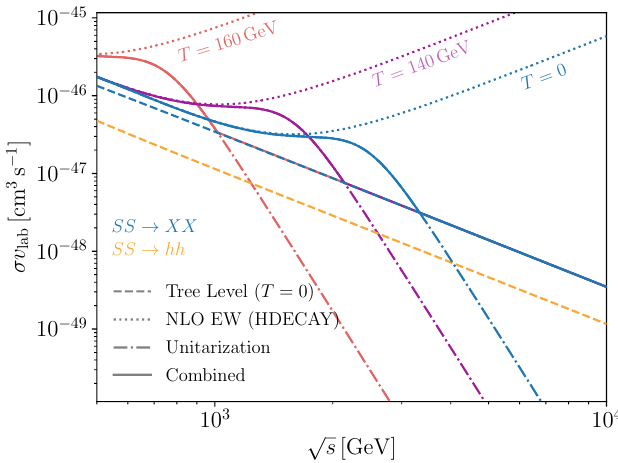
Figure 2 . Total annihilation cross section for the toy model introduced in eq. (4.6), for λ hs = 10 − 11 . The solid line shows the prescription that we adopt in this work, as stated in eq. (4.11), thus modifying the result based on the Higgs decay width returned by HDECAY (dotted line) such as to avoid unitary violation and falling back to the tree-level result (dashed line) at high CMS energies. Different colours show these results in the zero-temperature limit (blue), as well as for T = 140 GeV (purple) and T = 160 GeV (red). For comparison, the orange dashed line shows the full tree-level cross section into a pair of SM Higgs